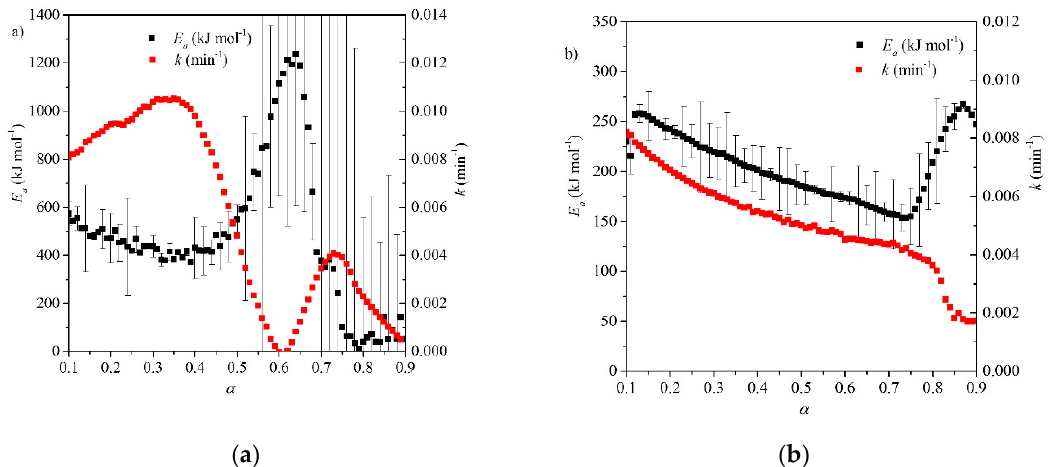
Figure 12. Isoconversional values of E α for CaCO 3 : ( a ) carbonation: under 100 v/v % CO 2 . ( b ) under 75 Figure 13. Isoconversional values of E α for CaCO 3 : ( a ) carbonation: under 100 v / v % CO 2 . ( b ) under v/v % N 2 / CO 2 . [46]. 75 v / v % N 2 / CO 2